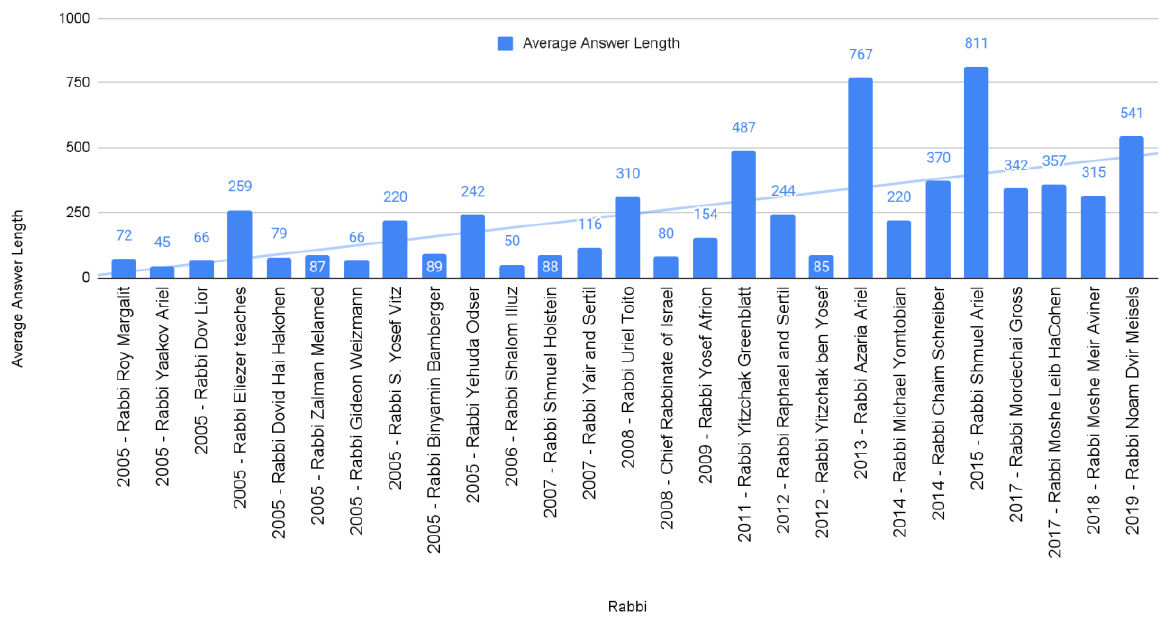
Figure 4. Average answer length of rabbis who answered over 200 questions. The newer rabbis on the platform provide answers that are more than three times the average of the earlier rabbis. See Appendix C for chart.